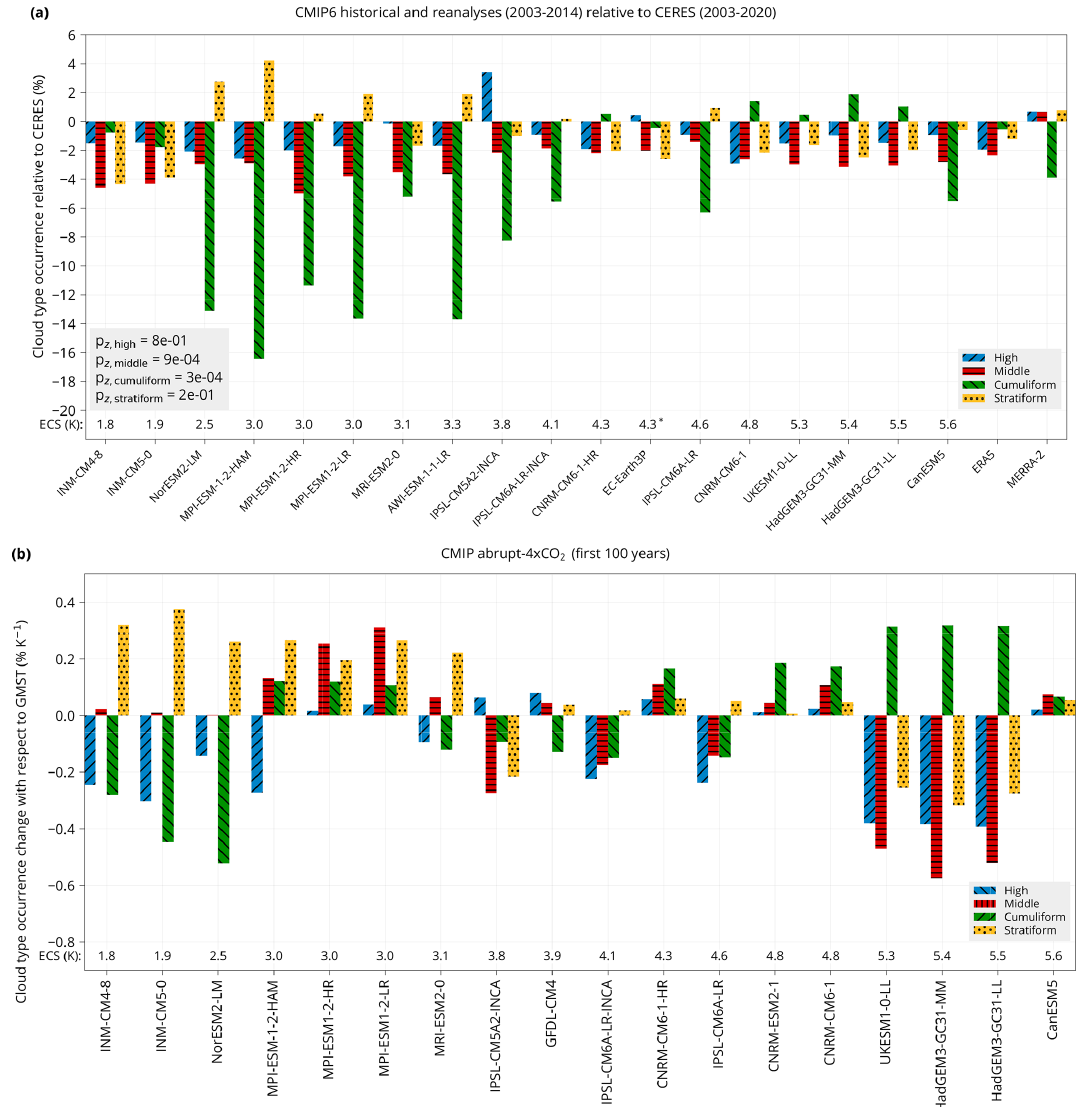
Figure 8. (a) Global mean cloud type occurrence in CMIP6 models and reanalyses relative to CERES in the historical experiment. Shown is also the p value of a z test for the difference in the means of two groups of CMIP models with ECS below and above 4K (the mid-point ECS in the range of the analysed models). (b) Global mean of cloud type occurrence change with respect to global mean near-surface air temperature (GMST) in CMIP5 and CMIP6, calculated by linear regression. Models are sorted by their equilibrium climate sensitivity (ECS). For some models, marked by “*”, ECS was not available and was taken from a related available model (see Table